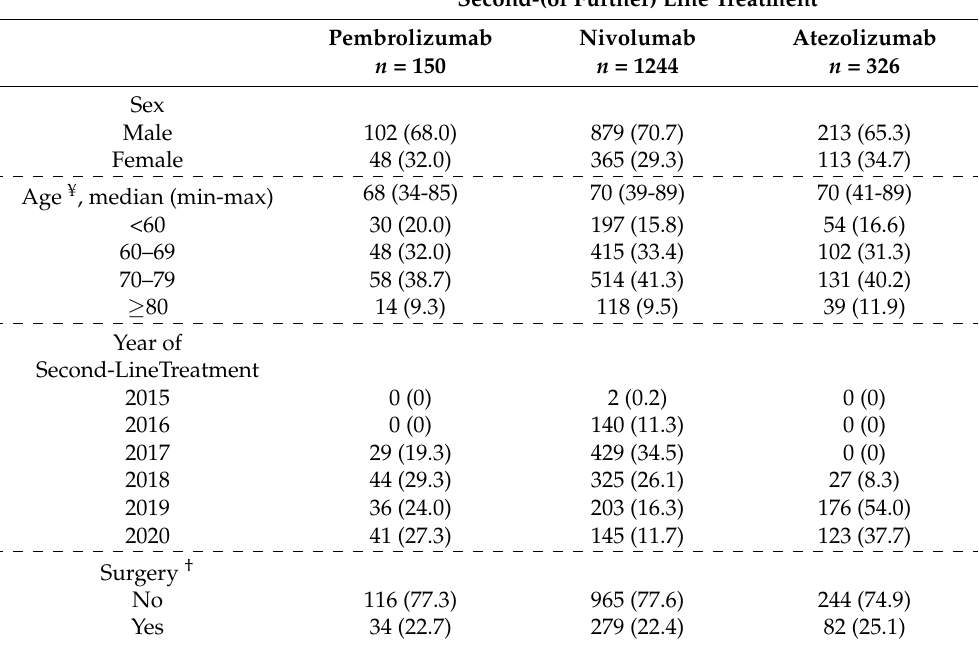
Table 3. Baseline characteristics of advanced NSCLC patients treated with second/further-line immune checkpoint inhibitors